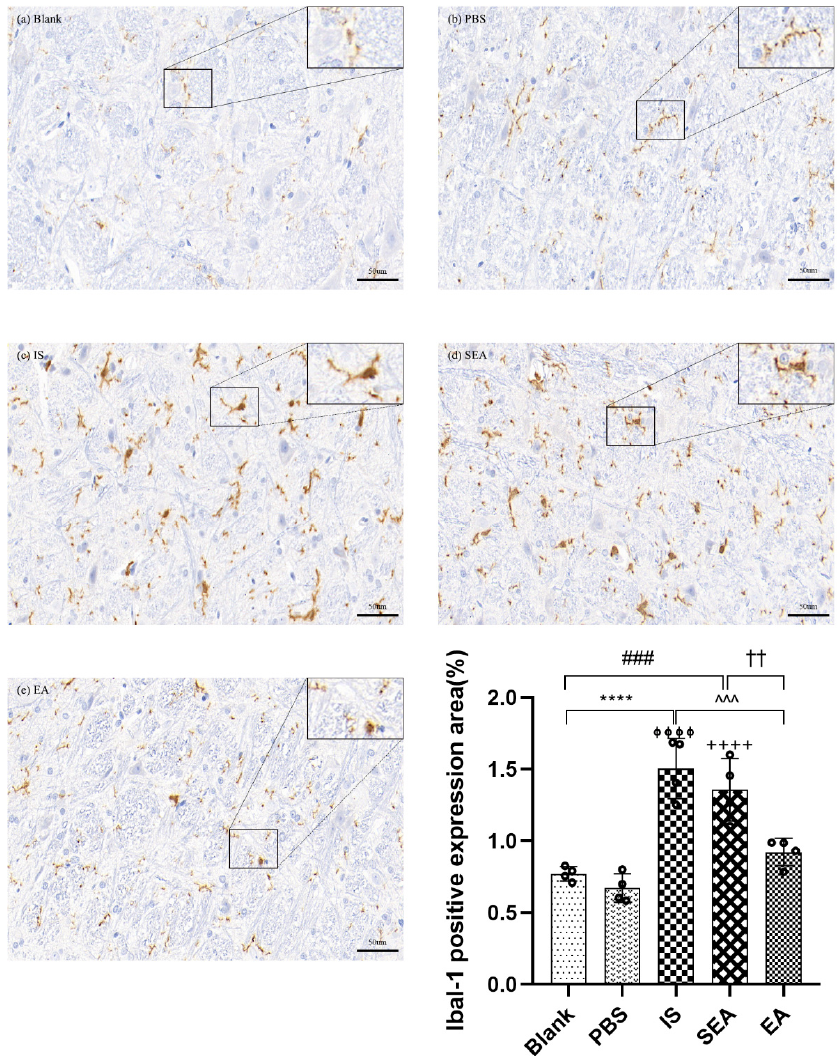
Figure 4. The positive expression of Iba-1-labeled microglia in TNC in five groups of rats (( a ): Blank; ( b ): PBS; ( c ): IS; ( d ): SEA; ( e ): EA) and the percentage of positively expressed area in the total observed area (area%) ( n = 4/group). Images of microglia labelled with Iba-1 IHC staining in TNC (400×, Scale bar = 50 μ m, three sections/rat). Repeated IS infusions into dura induced the microglial activation (morphological hypertrophy and increase in positive cell expression), whereas EA reduced the activation of microglia. ANOVA and Tukey’s post hoc analysis test were performed and data are presented as the mean ± standard deviation. **** p < 0.0001, Blank vs.